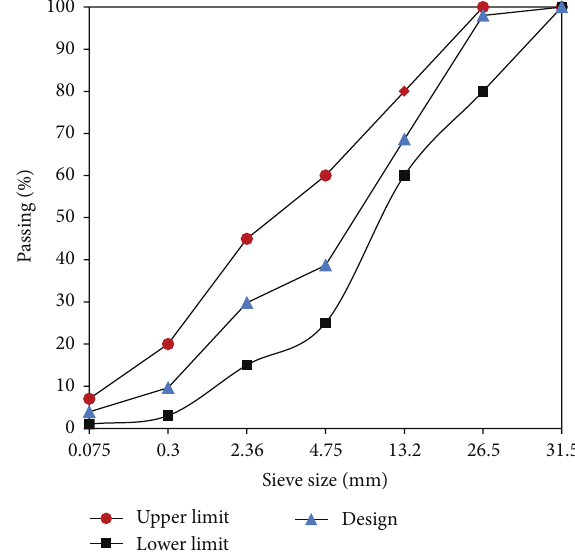
Figure 1: Gradation of